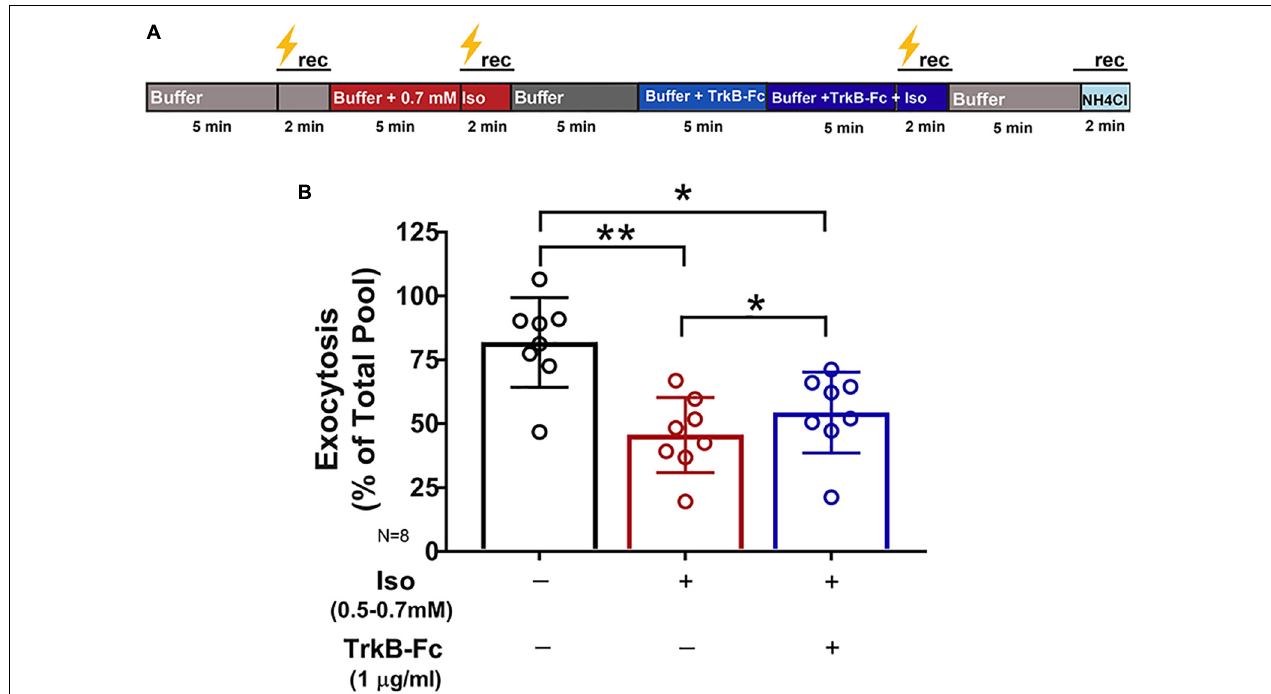
FIGURE 4 | Inhibition of synaptic vesicle exocytosis by isoflurane is attenuated by reducing endogenous BDNF. Rat hippocampal neuron cultures (16DIV) transfected with vGlut-pH and mCherry were perfused with control buffer, 0.5–0.7 mM isoflurane, or TrkB-Fc (1 µ g/ml) + 0.5–0.7 mM isoflurane with tetanic stimulation (lightning bolt) as indicated in (A) . (B) Synaptic vesicle exocytosis evoked by tetanic stimulation was reduced by isoflurane (0.5–0.7 mM) (** p < 0.01 by multiple comparisons one-way ANOVA with Dunnett’s post-hoc test). Reduced exocytosis observed with isoflurane exposure was attenuated by pretreatment with TrkB-Fc (1 µ g/ml) for 5 min prior to stimulation (* p < 0.05 by multiple comparisons one-way ANOVA with Dunnett’s post-hoc test). Data are mean ± SD; n = 8 neurons per experimental group and 327–400